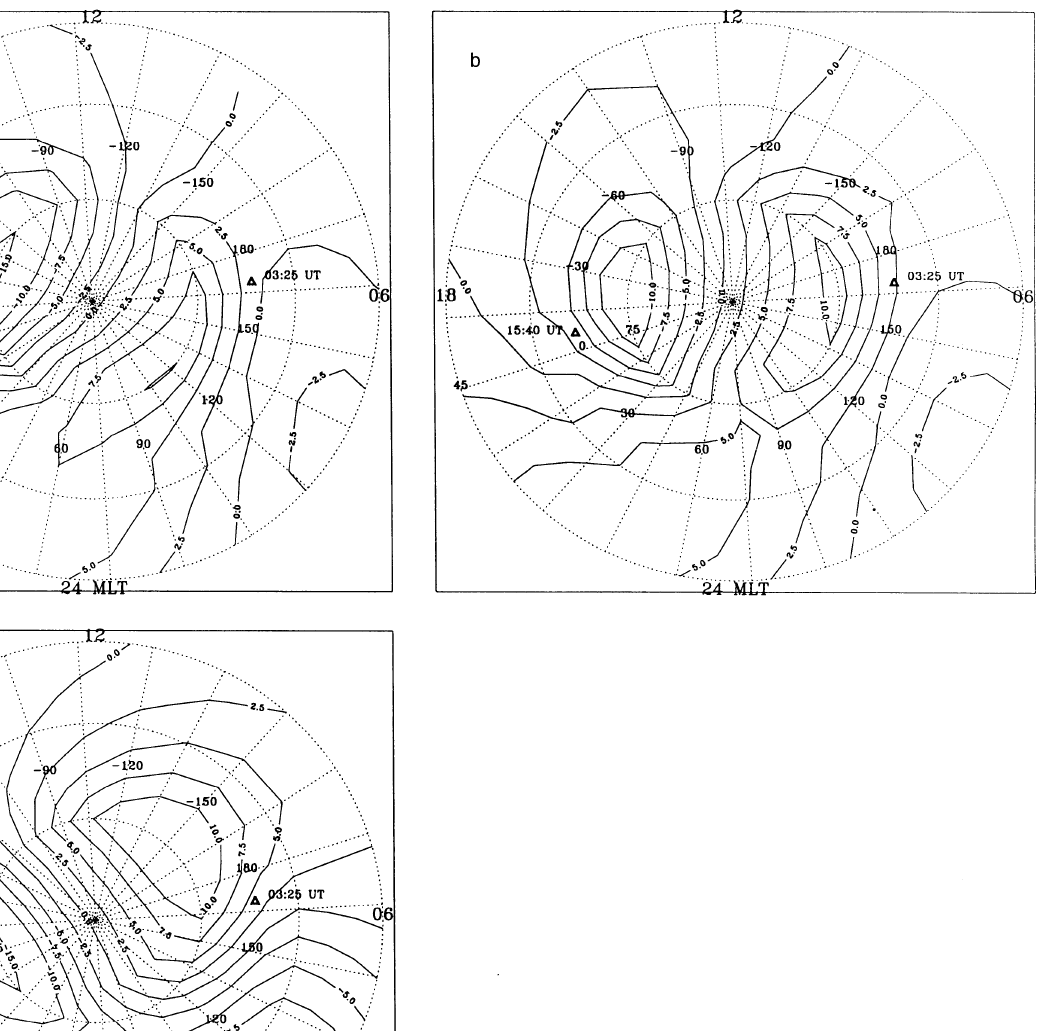
Fig. 11a – c. Electric-field-potential (kV) distribution at the northern hemisphere in a geomagnetic latitude/longitude frame with ortho- graphic projection for three different FAC patterns: a maximum FACs in the 06 — 18-MLT, b 08 — 20-MLT c and 10 — 22-MLT meridi- onal plane. The location of the EISCAT station for the two different time-moments is indicated by